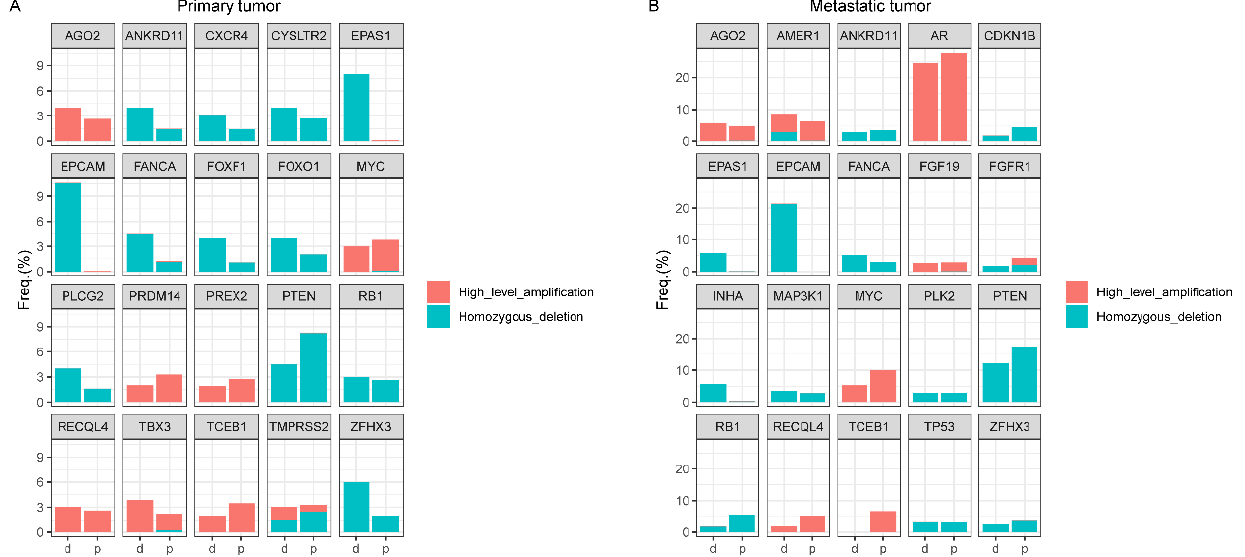
Figure 5. Copy number variant frequency in MMR-d and MMR-p tumors. Plots correspond to ( A ) primary and ( B ) metastatic tumors. Only the most frequently altered candidate genes are shown in the figure. MMR-d = mismatch repair-deficient; MMR-p = mismatch repair-proficient; d = mismatch repair-deficient; p = mismatch repair-proficient.